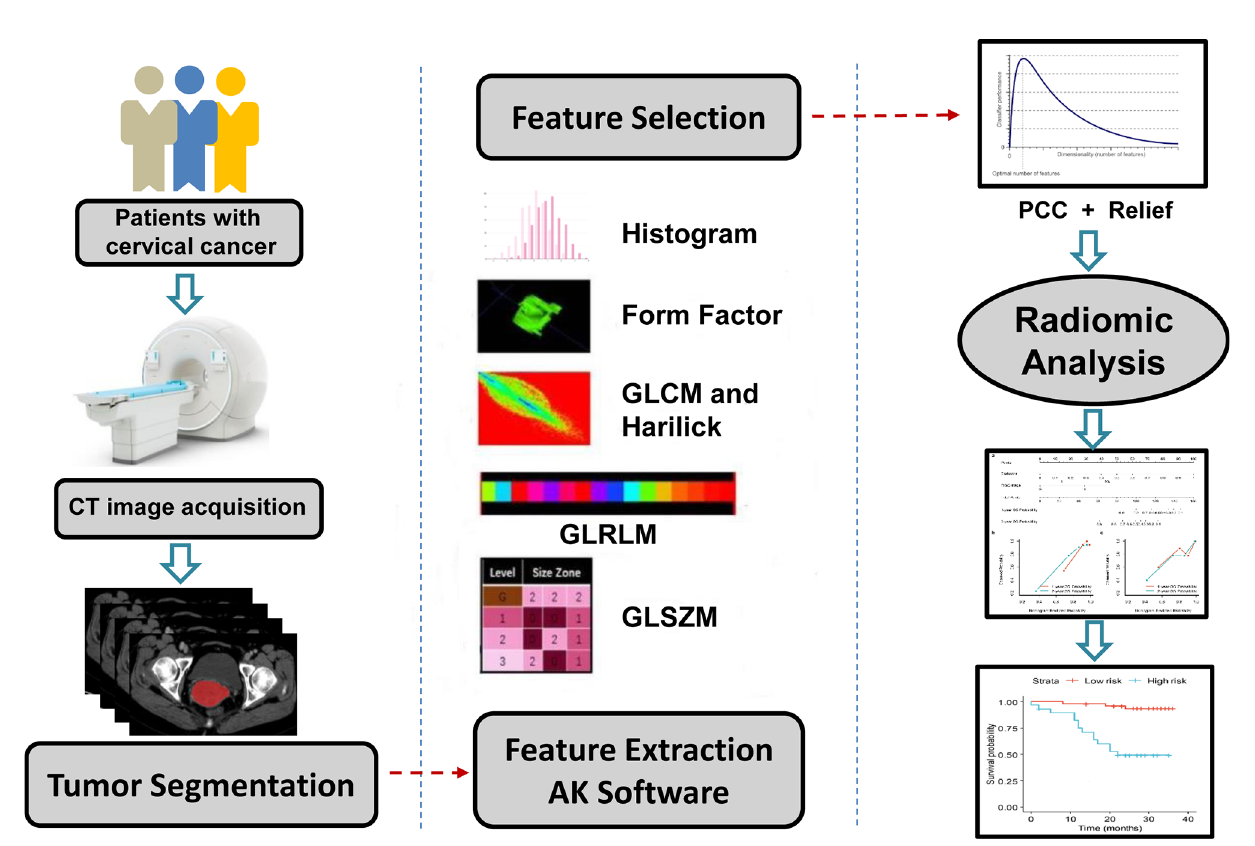
FIGURE 1 | Schematic diagram exhibition of the radiomic work fl ow. A radiomic study design and work fl ow mainly include (I) Image segmentation, (II) Radiomic feature extraction, (III) Dimension reduction and feature selection, (IV) Statistics analysis and model building. CT, computed tomography; GLCM, gray-level co- occurrence matrix; GLZSM, gray-level size zone matrix; GLRLM, gray-level run-length matrix; PCC, Pearson correction coef fi